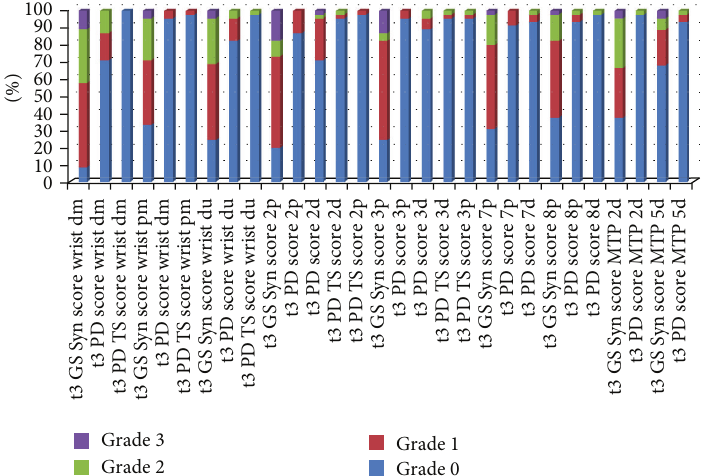
Figure 4: Semiquantitative analysis of each joint region included in the US7 score (without erosions)—one-year followup (t3). Legend: Syn = synovitis; TS = tenosynovitis/paratenonitis; GS = greyscale; PD = power Doppler; dm = dorsomedian; pm = palmomedian; du = dorsoulnar; 2p = MCP II palmar; 2d = MCP II dorsal; 3p = MCP II palmar; 3d = MCP III dorsal; 7p = PIP II palmar; 7d = PIP II dorsal; 8p = PIP III palmar; 8d = PIP III